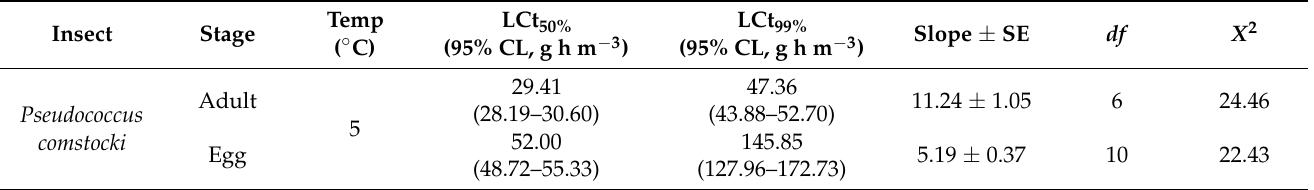
Table 1. Efficacy of fumigation with ethyl formate for 4 h during different developmental stages